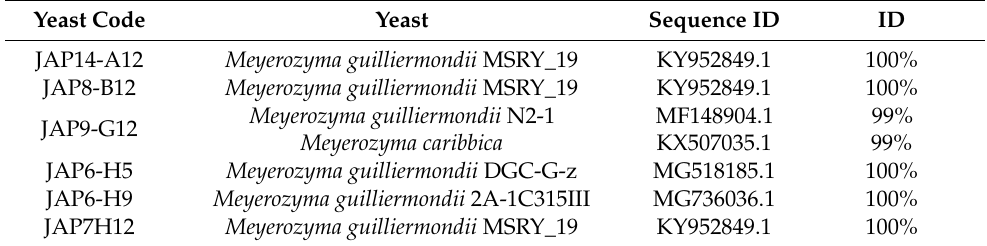
Table 1. Taxonomic identification of the selected yeast strains. The D1 / D2 region sequence similarity is indicated.